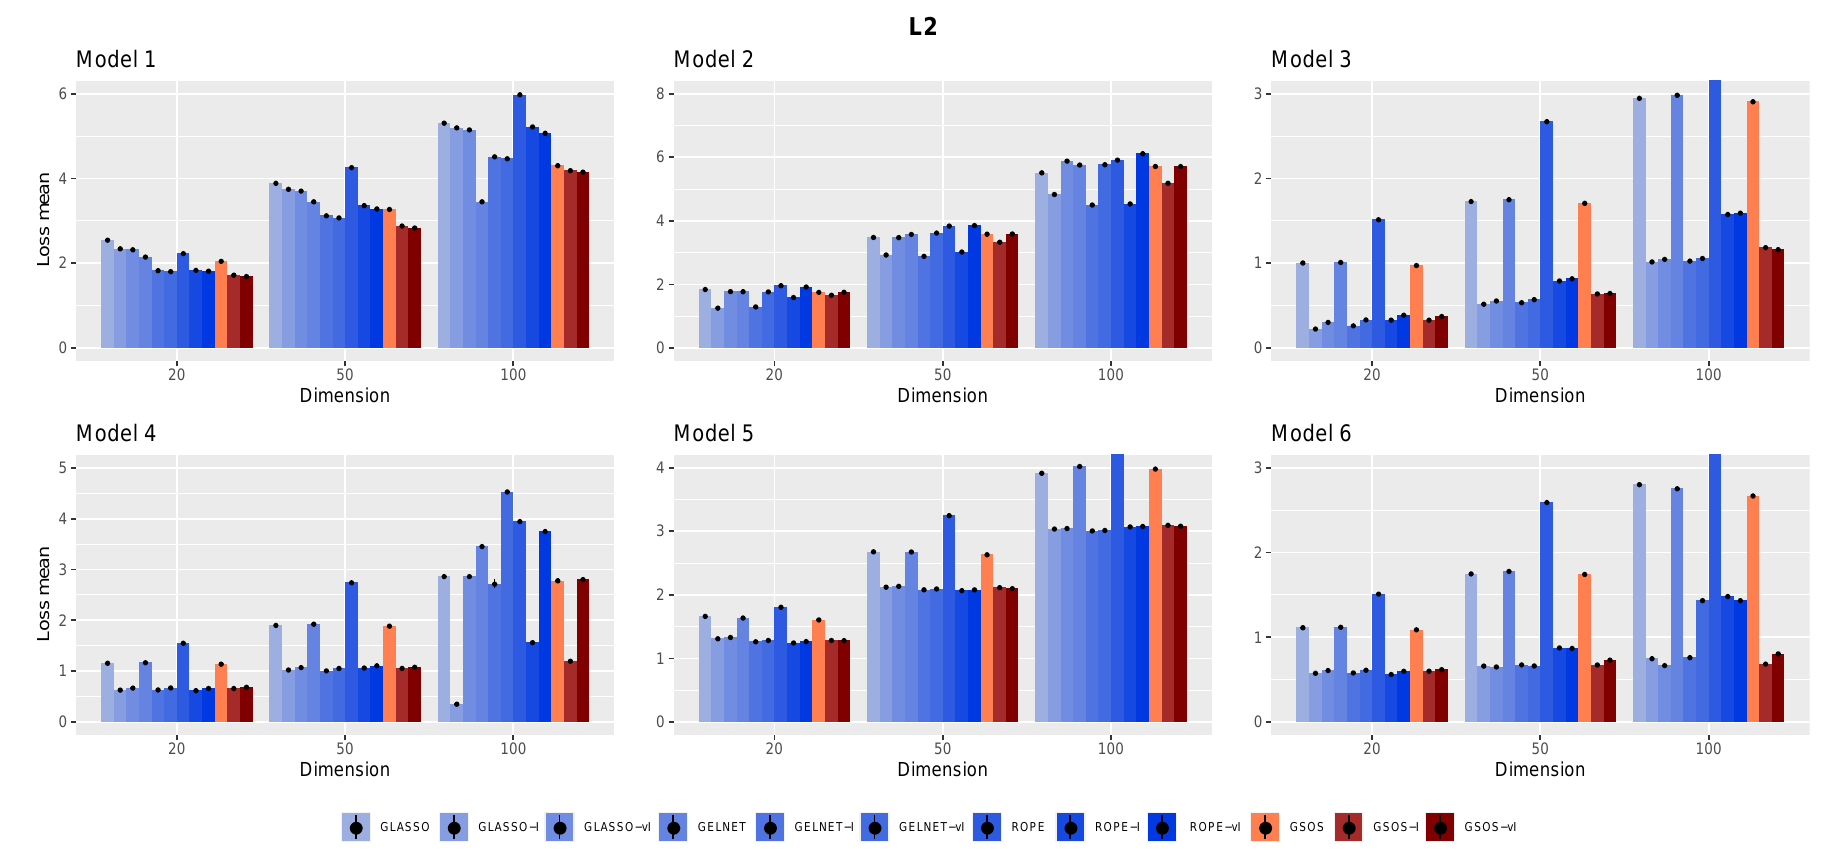
Figure 2. The mean of L 2 loss for the different models and methods based on 100